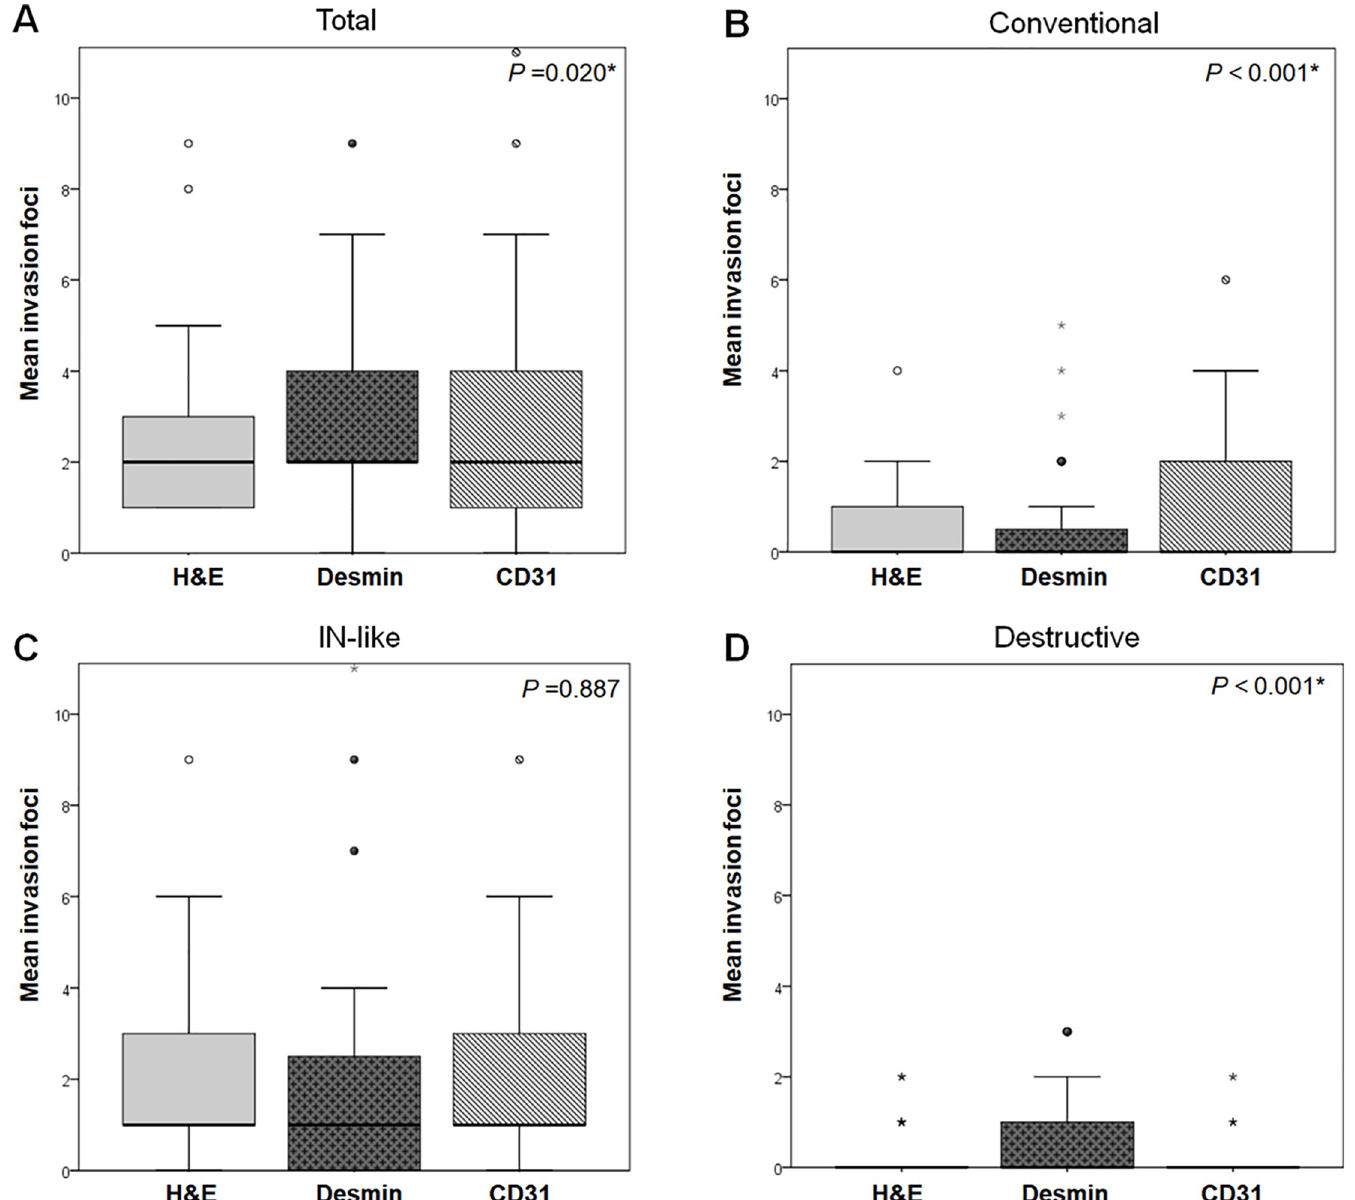
Fig 4. Comparisons of mean foci number of VI of pancreatobiliary tract cancers in the test set. (A) Total foci of venous invasion regardless of invasion pattern. Invasive foci of the (B) conventional, (C) IN-like, and (D) destructive patterns, as assessed by H&E staining and desmin and CD31 immunolabeling in the test set. (A) The mean total number of foci of VI regardless of invasion pattern detected by CD31 ( P = 0.022) and desmin ( P = 0.027) immunolabeling is significantly higher than that detected by H&E staining. (B) CD31 immunolabeling detected more invasion foci of the conventional pattern of VI than H&E staining ( P < 0.001). (C) There is no significant difference in the detection of the IN-like pattern of VI by H&E staining, desmin, and CD31 immunolabeling. (D) Desmin immunolabeling detected more invasion foci of the destructive pattern ( P < 0.001).